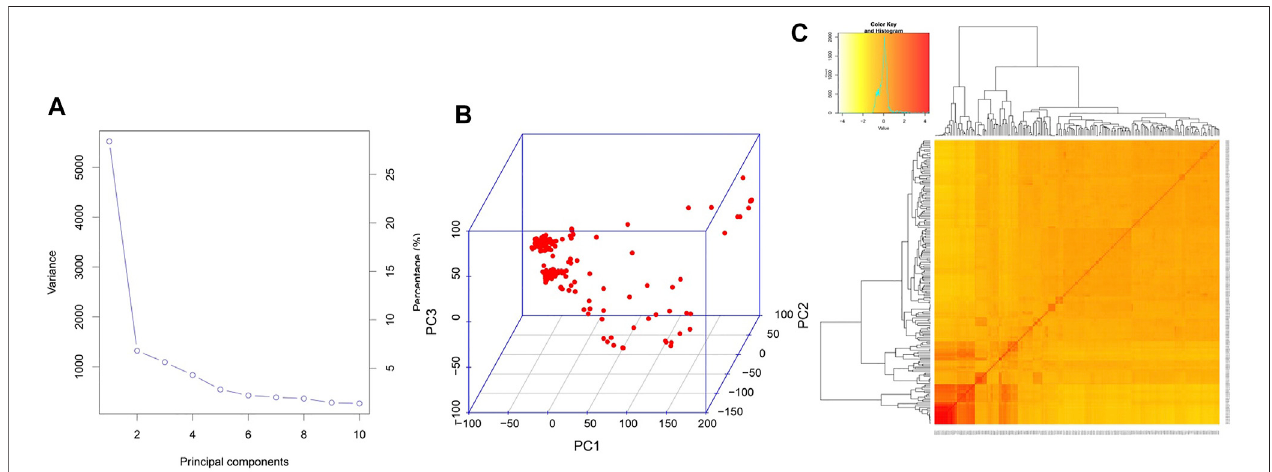
FIGURE 3 | (A) Scree plot depicting the proportion (%) of total variance captured by various principal components. (B) PCA 3D plot illustrating the distribution of genotypes across three principal components. (C) Pair-wise kinship heat map between the genotypes. The fi gure in the inset describes the color code of the heat map and the frequency curve of kinship values among the